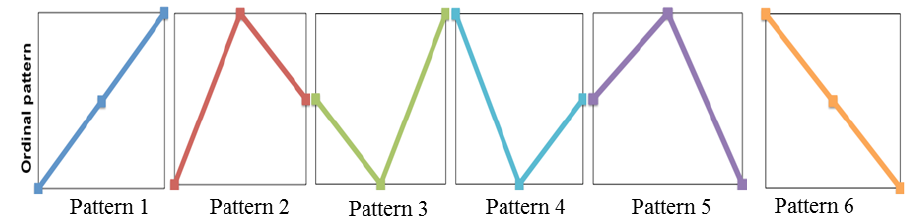
Figure 2. Permutation Entropy (PE) ordinal patterns for m = 3.